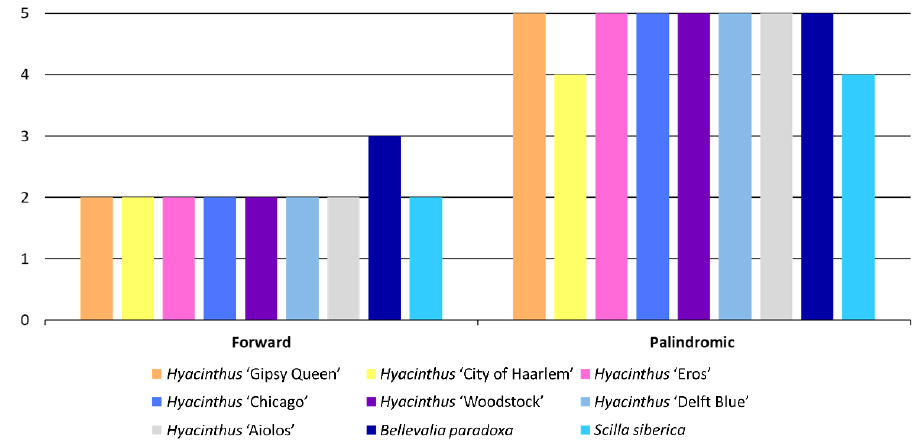
Figure 7. Abundance of LTRs by types among the nine studied chloroplast genomes.